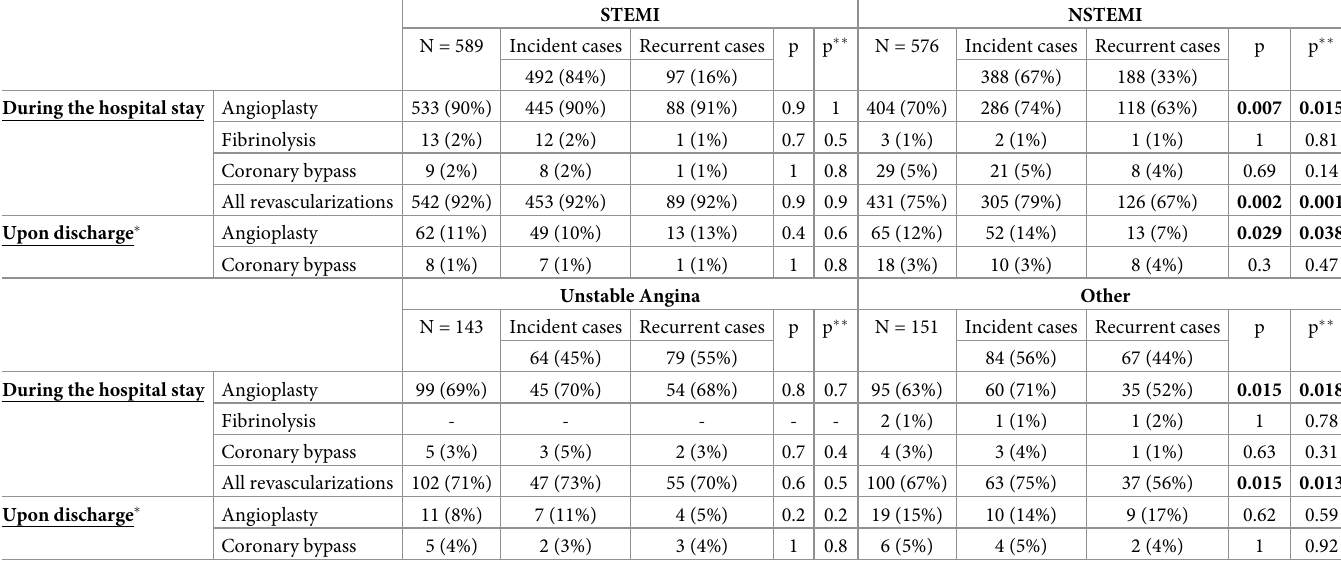
Table 3. Reperfusion therapy during the hospital stay and at discharge in patients admitted to hospital for an incident or recurrent acute coronary syndrome, according to the type of event (STEMI, NSTEMI, UA, and other events).